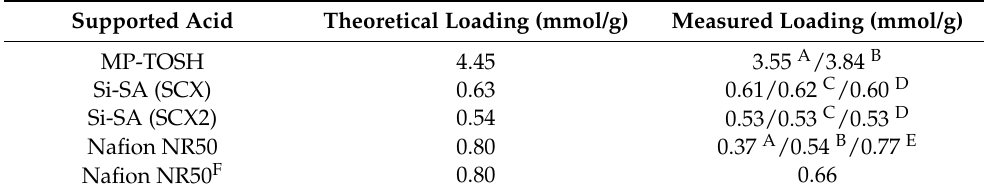
Table 2. Loading results for the supported acids using PhNH 2 in MeCN.